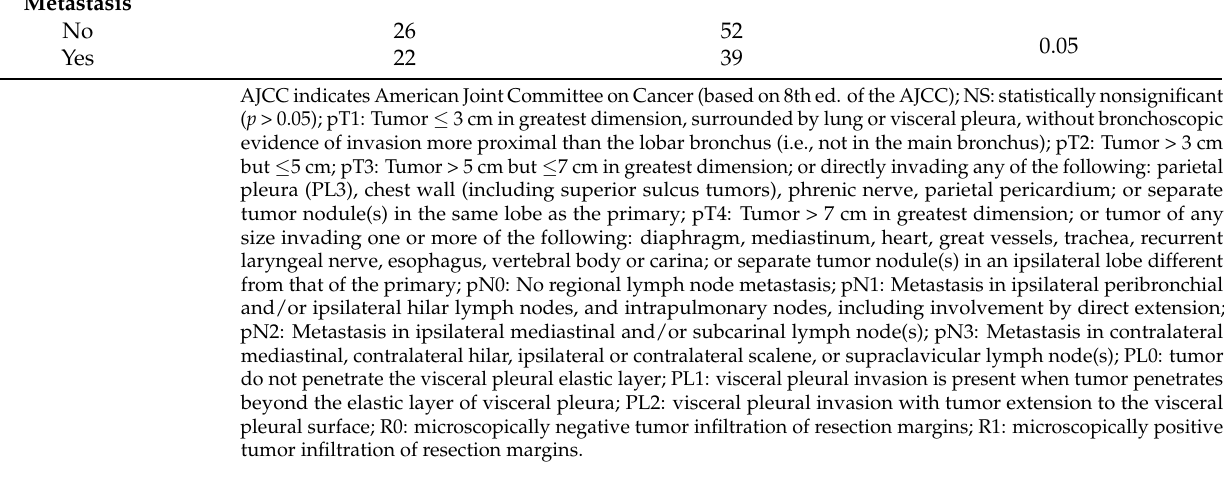
Table 2. Frequency of distinct numerical and structural chromosomal abnormalities identified for each chromosome and chromosome region analyzed in 48 pulmonary squamous cell carcinoma (SCC) patients detected using FISH and their impact on overall